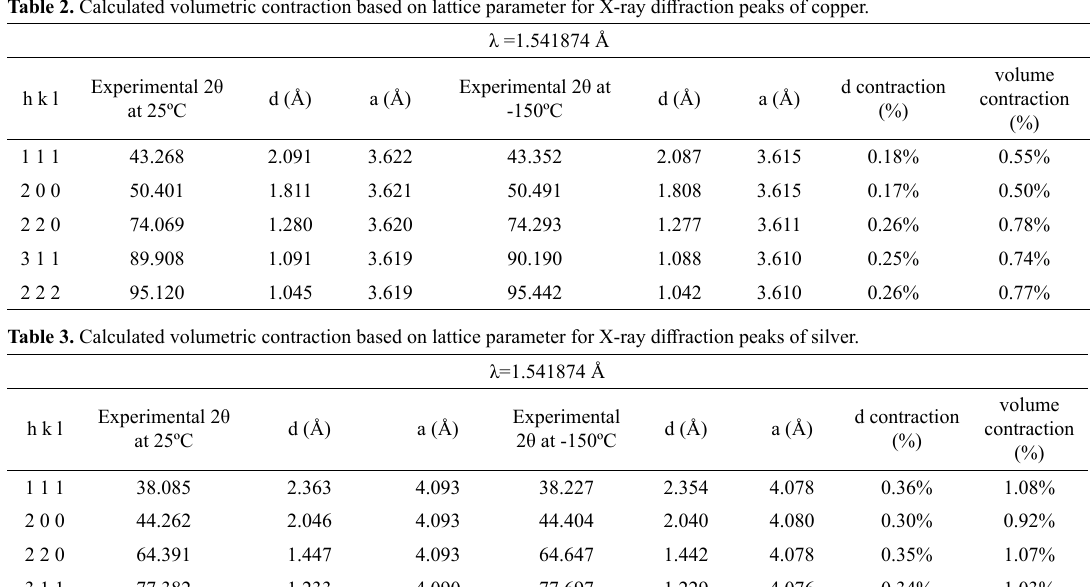
and the volume of the unit cell were estimated for the identified peaks. The volumetric contraction in silver was higher than in copper. Table 4 displays the values of cumulative roll reduction, microstrain, crystallite size and dislocation density for rolled samples at RT and CT. It is shown that the crystallite size parameter does not change for this high deformation degree, so a steady state grain size is reached for copper and silver. Also in Table 4, it can be observed a significant increase in dislocation density and microstrain, at cryogenic temperatures compared to room temperature, especially for silver, of lower SFE. This phenomenon can be explained by lower dynamic recovering level, for lower SFE λ =1.541874 Å